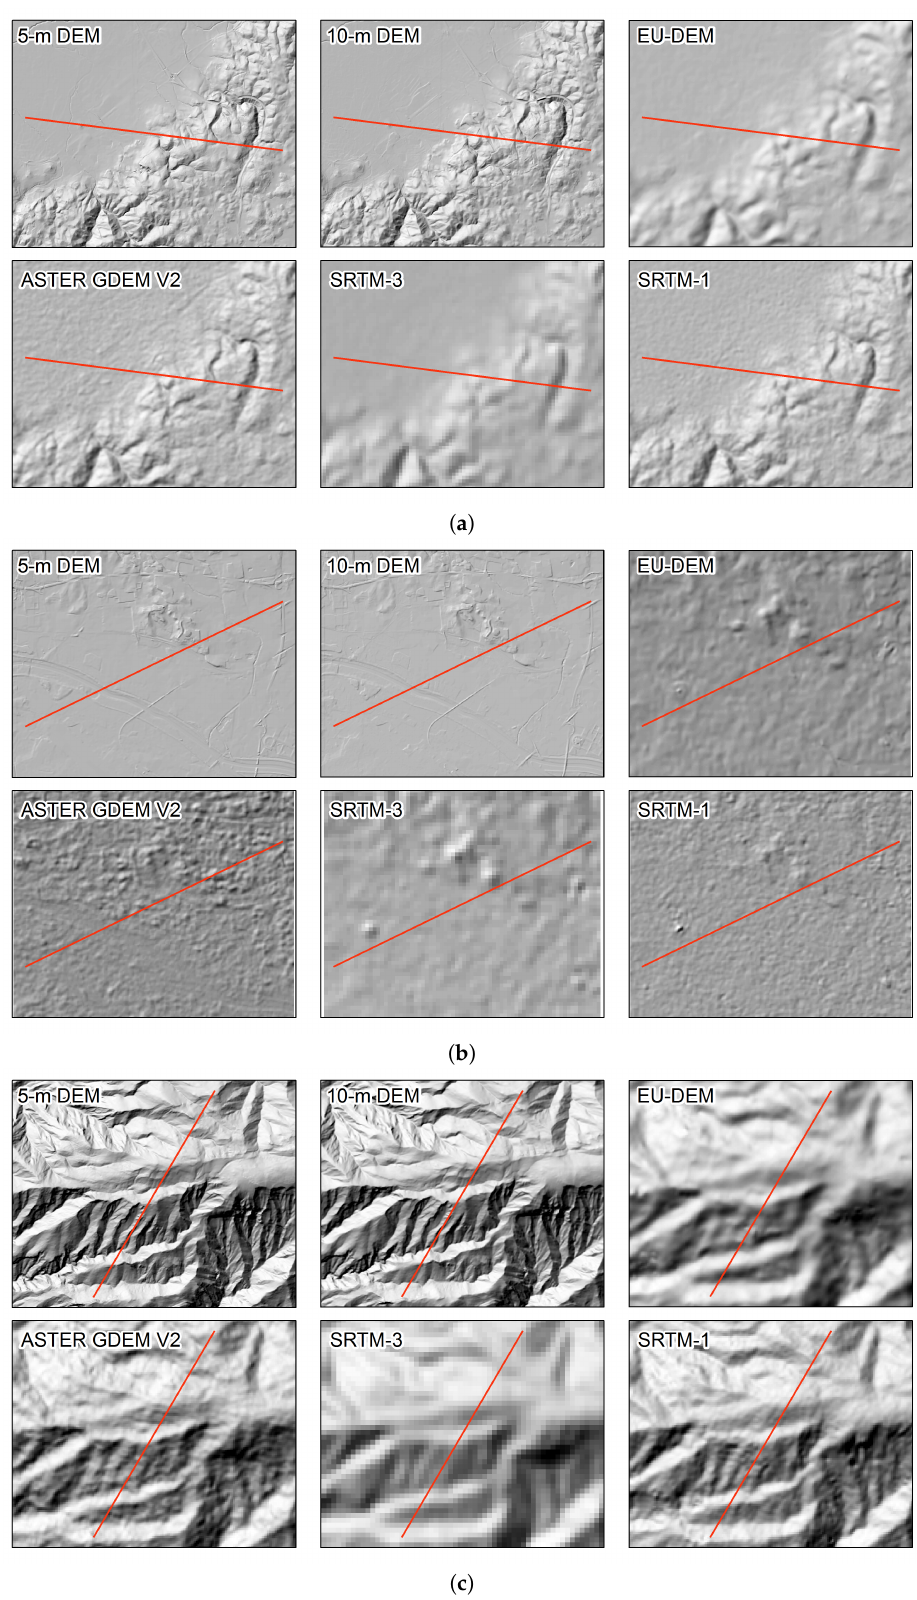
Figure 5. Hillshades of the various DEMs. ( a ) Profile 1; ( b ) Profile 2; ( c ) Profile